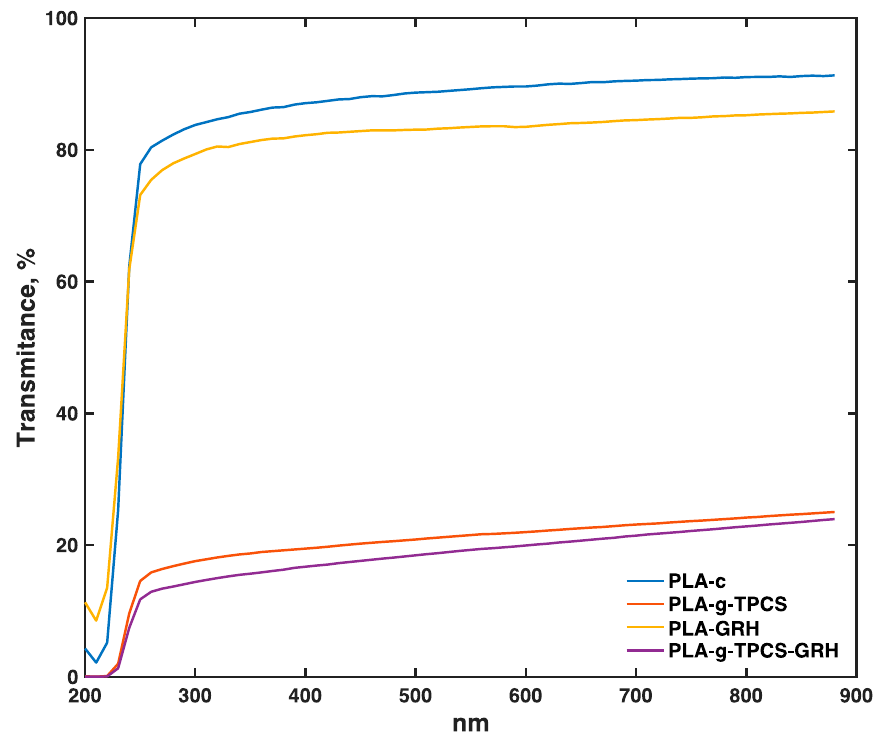
Figure 7. Transmittance (%) of film samples produced by twin-screw extrusion–cast-film extrusion.